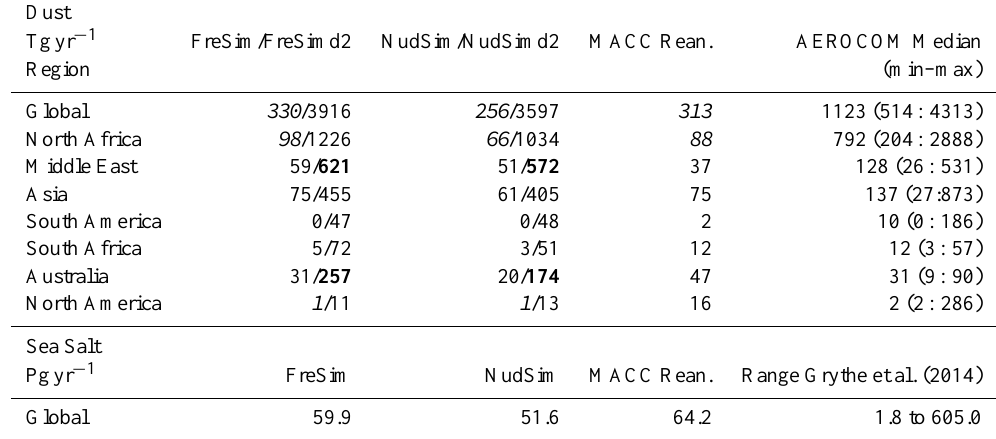
Table 5. Upper part of the table: dust emissions (Tgyr − 1 ) over regions defined in Huneeus et al. (2011), for the FreSim and FreSimd2 simulations, the NudSim and NudSimd2 simulations (year 2004), the MACC Reanalysis (2003–2012 mean), and results from 15 AEROCOM models analysed in Huneeus et al. (2011), median, min, and max values. In italic font, totals lower than the AEROCOM min, in bold